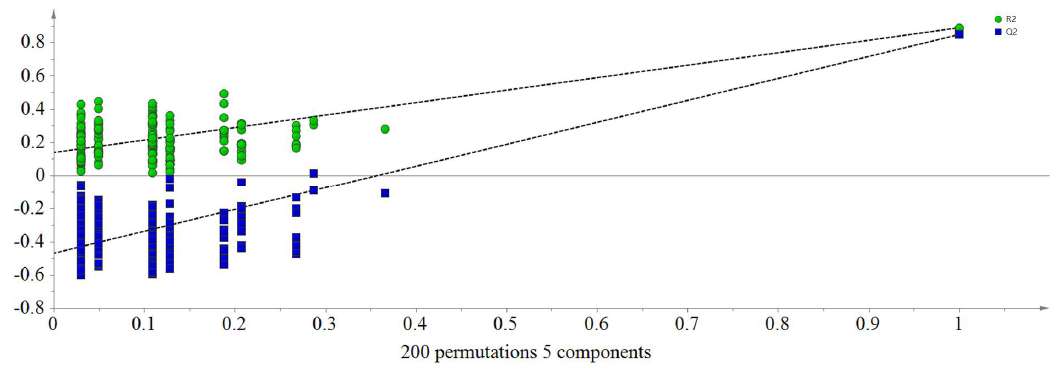
Figure 3. Permutation test (200 cycles, R2 = 0.888, Q2 = 0.847).